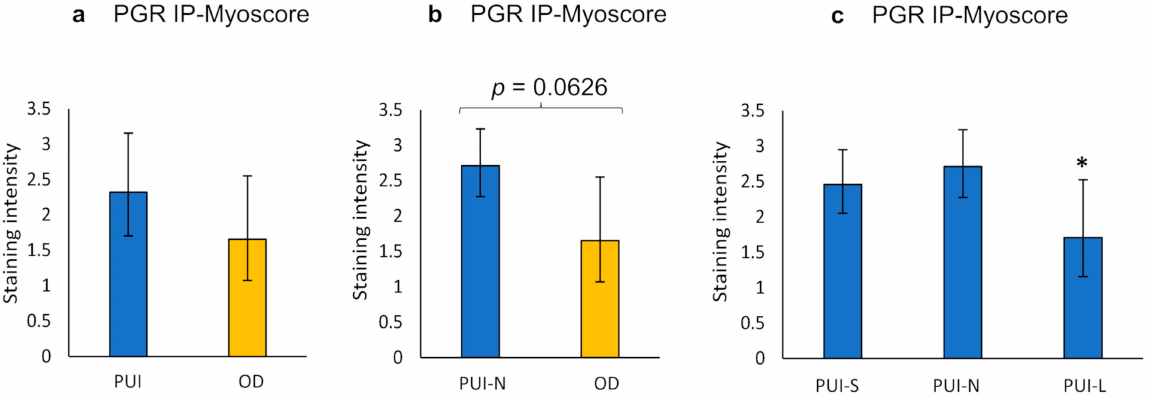
Figure 7. Interplacental myometrial staining score (IP-Myoscore) for PGR in PUI ( n = 12), PUI-N ( n = 4), and OD ( n = 8) as obtained by immunohistochemistry. Comparison of IP-Myoscore of ( a ) PUI or ( b ) PUI-N, respectively, and OD and ( c ) within PUI subgroups according to litter size. Results are presented as geometric means with dispersion factor. Asterisks show significant differences (* p <